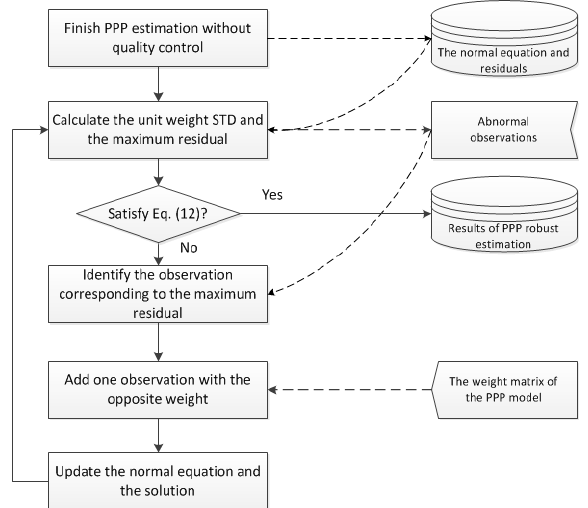
Figure 1. The flow chart of the quality control using the additional observation with opposite weight and the real-time robust precise point positioning (PPP) implementation (Eq.: Equation; STD: standard deviation; and the dashed lines denote data